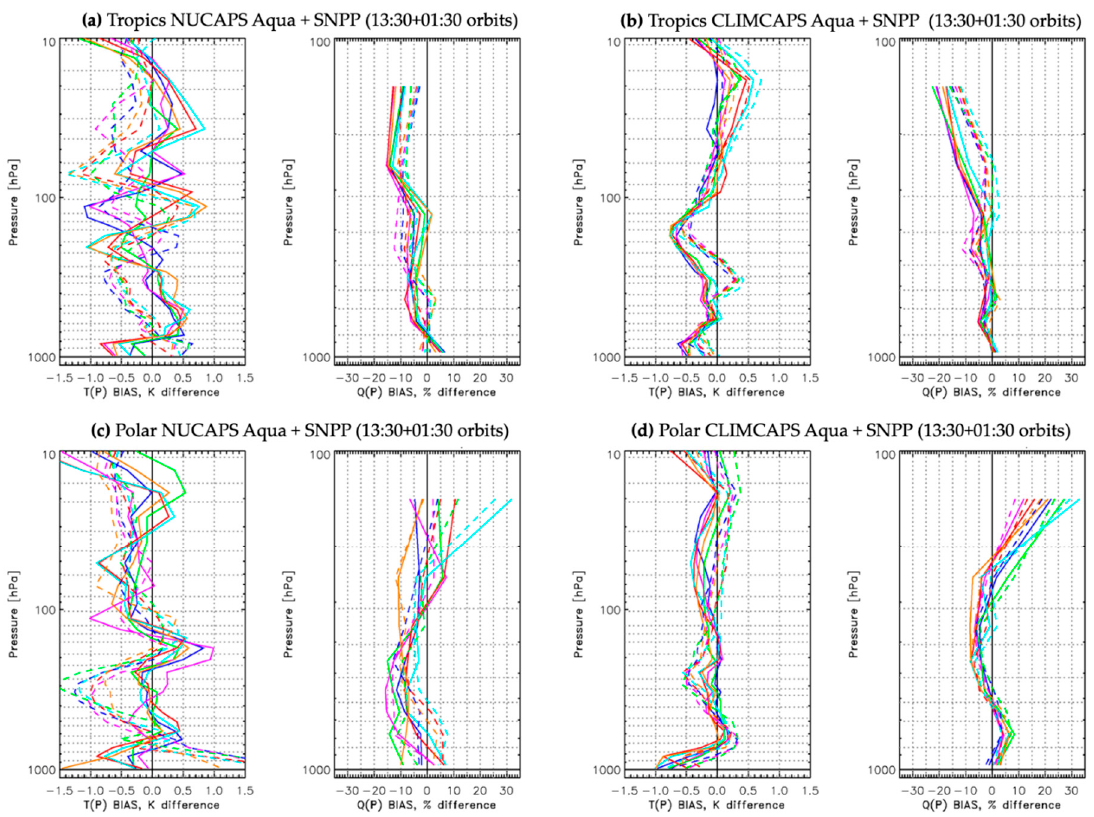
Figure 12. Regional statistics of ( a , c ) NUCAPS from SNPP / CrIS (solid lines) and Aqua / AIRS (dashed lines) as well as ( b , d ) CLIMCAPS from SNPP / CrIS (solid lines) and Aqua / AIRS (dashed lines) as the bias with respect to ECMWF of temperature T(p) in units Kelvin and moisture Q(p) as percent profiles from six focus days for ( top row ) Tropical latitudes ( < 30 ◦ north and south) and ( bottom row ) Polar latitudes ( > 60 ◦ north and south).